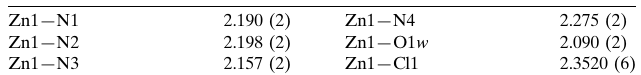
Selected bond lengths (A˚ ).